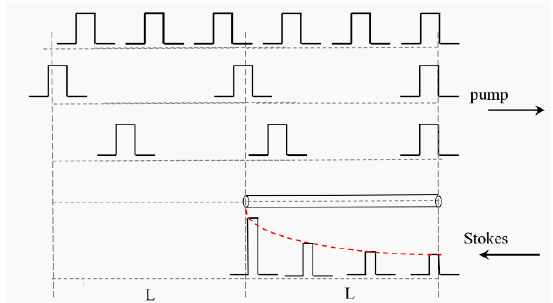
Figure 3. Schematic of the interaction between Brillouin pump and Stokes waves for optical pulse in optical fiber.